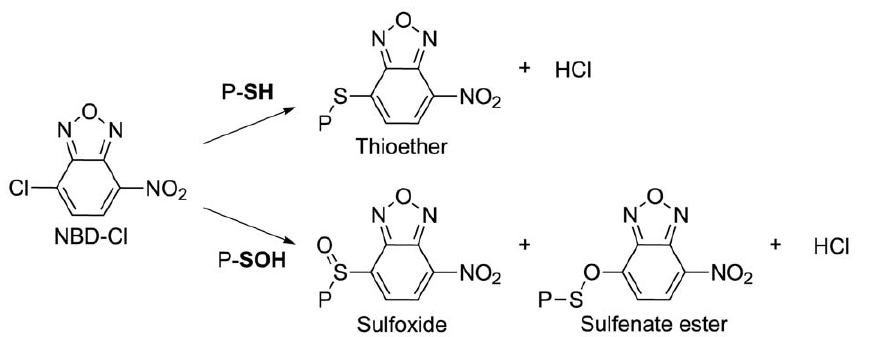
Figure 5. Reactions of NBD-Cl with protein cysteine and sulfenic acid states. Schematic diagram showing steps involved in reaction of NBD- Cl with cysteine and sulfenic acid.